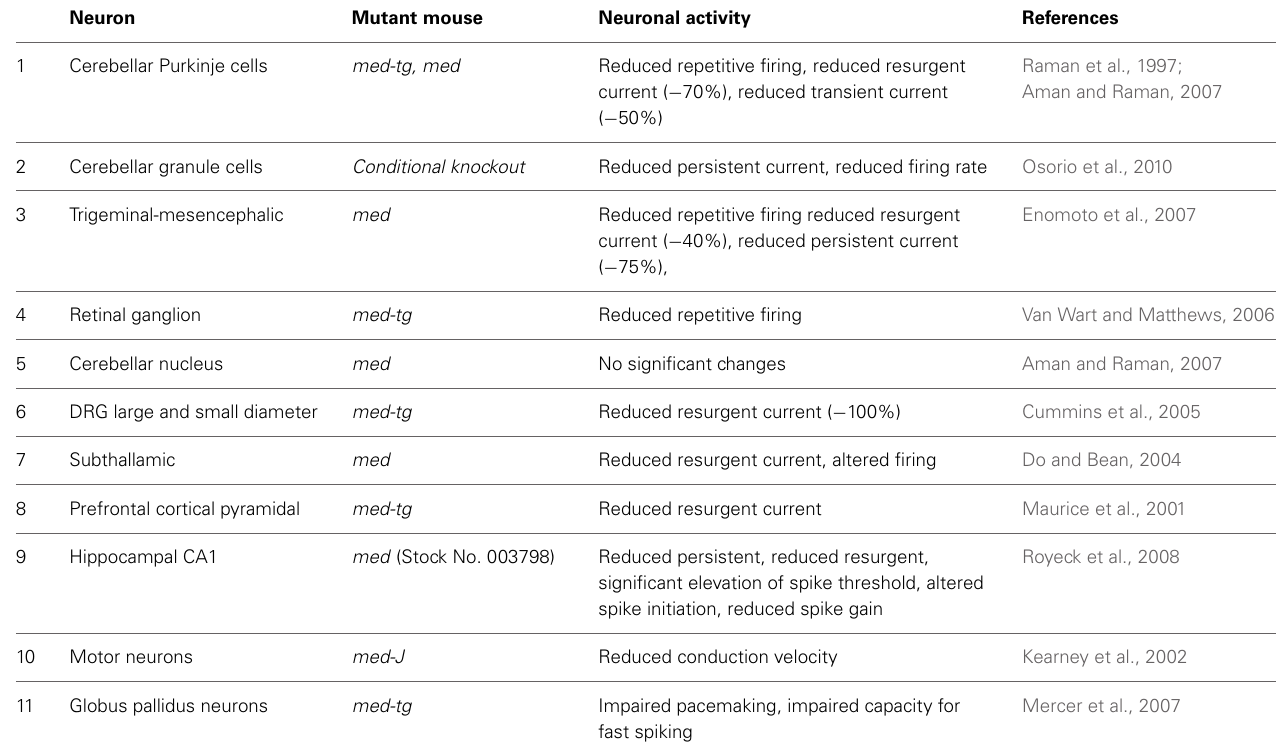
Table 1 | Reduced activity of neurons from Scn8a null